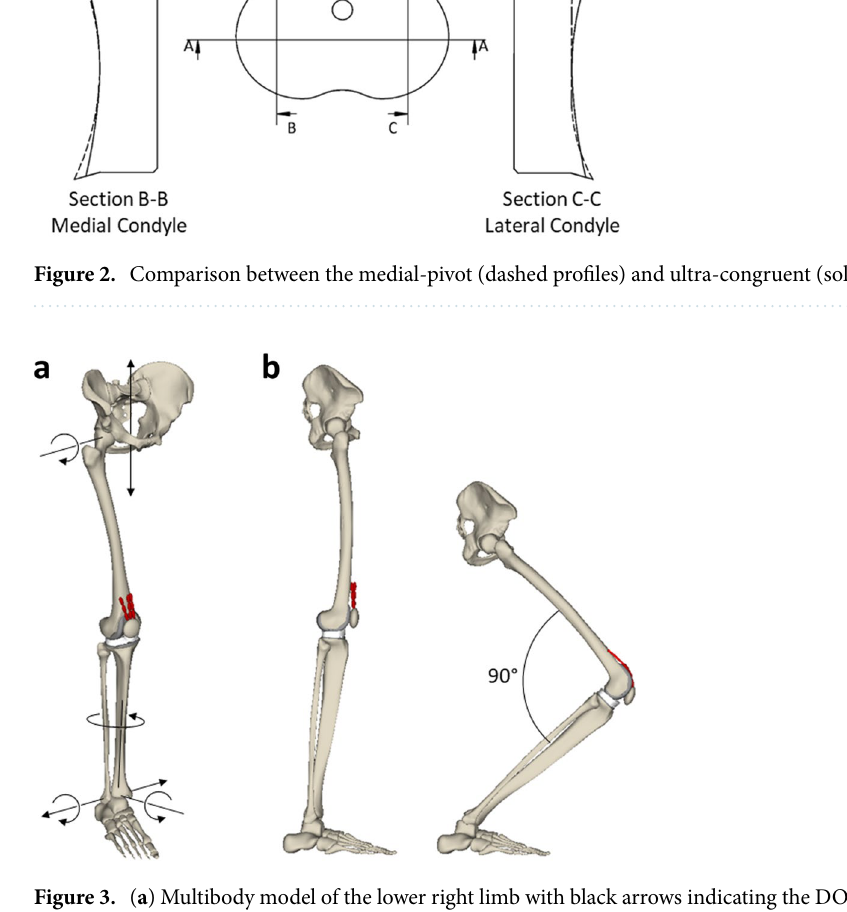
Squat simulation. To compare the knee joint dynamics resulting from the different insert designs, a weight- bearing squat simulation was performed, within the gravitational field, by assigning a mass fraction of 29.3 kg to the pelvis. Such mass fraction was derived through the sum of the masses of the body segments (head, neck, upper arm, forearm, hand, trunk, and thigh) computed as a percentage of the whole-body mass 34 for a male subject of 66.7 kg. In particular, only half of the resulting mass value for trunk, head and neck was taken into account since it was assumed an equal distribution of the load between the two lower limbs. During the squat motion, the pelvis was constrained to translate along the vertical direction, and the flexion movement was allowed at the hip joint (Fig. 3a). All six degrees of freedom (DOF) were permitted for the patel- lofemoral joint. Moreover, the tibia was constrained to the foot through the ankle joint which was defined to prevent vertical and anteroposterior relative translations 35 . The tibia and fibula were assumed to be one rigid body. Finally, the foot was ground-fixed. The knee flexion was achieved by defining a specific vertical displacement for the femoral head center, hence, the implemented PID controller continuously adjusted the quadriceps muscle forces to follow the target vertical trajectory, generating a knee flexion from the extended position to 90° flexion (Fig. 3b) in about 2.2 s 36 . This flexion range was chosen since, especially for most patients subjected to TKA, it represents a reasonable range of motion achieved during daily activities.